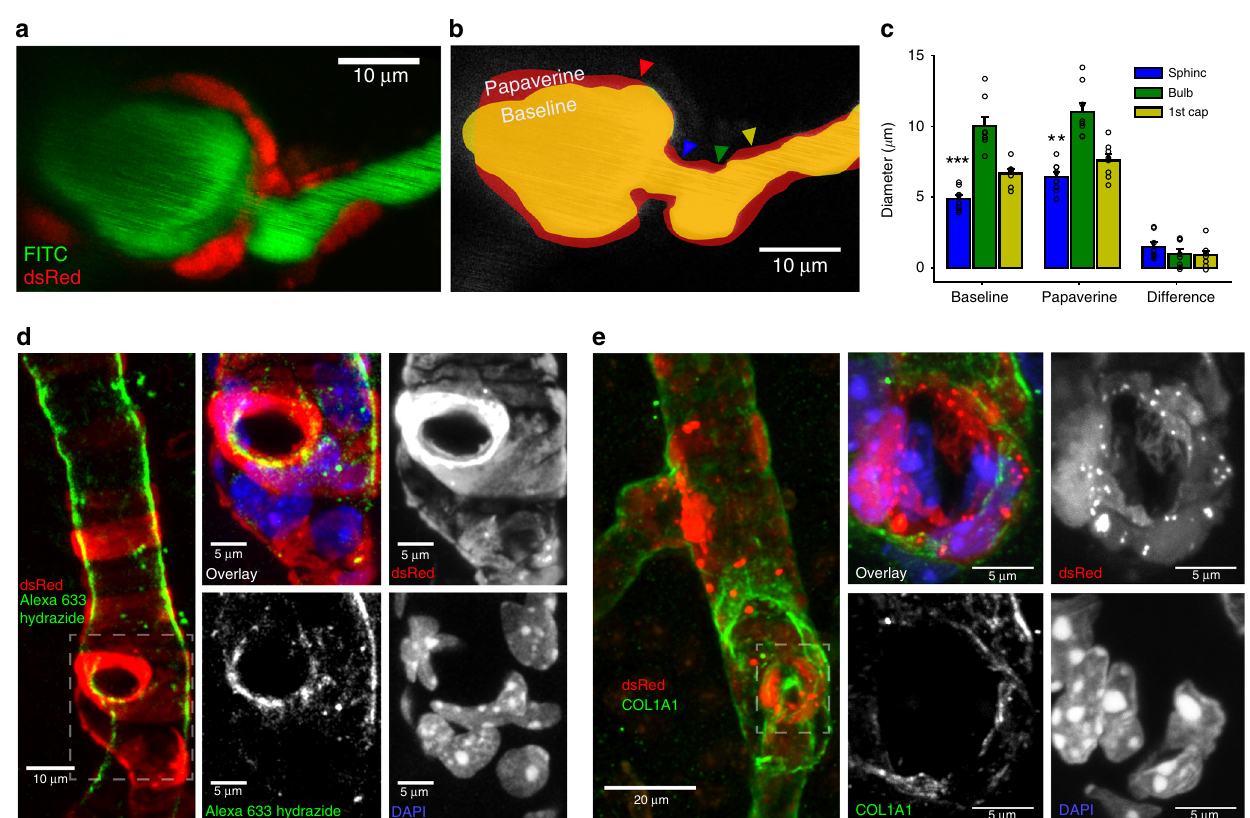
Fig. 5 Passive structural elements limit vasodilation. a – d Papaverine (10 mM) was locally injected into the vicinity of precapillary sphincters to dilate the nearby vasculature. a Representative maximal intensity projection of an NG2-dsRed mouse PA branch point. b Schematic of the papaverine-induced dilation (red) below an outline of the vessel lumen at baseline (yellow). The ROI locations in individual vessel segments are marked by colored arrows. c Absolute diameters of vessel segments at baseline and after papaverine addition, and the difference before and after papaverine addition. The baseline dataset was analyzed by the Kruskal – Wallis test, followed by a Wilcoxon rank-sum test (with Holm ’ s p value adjustment) for pairwise comparisons, n =